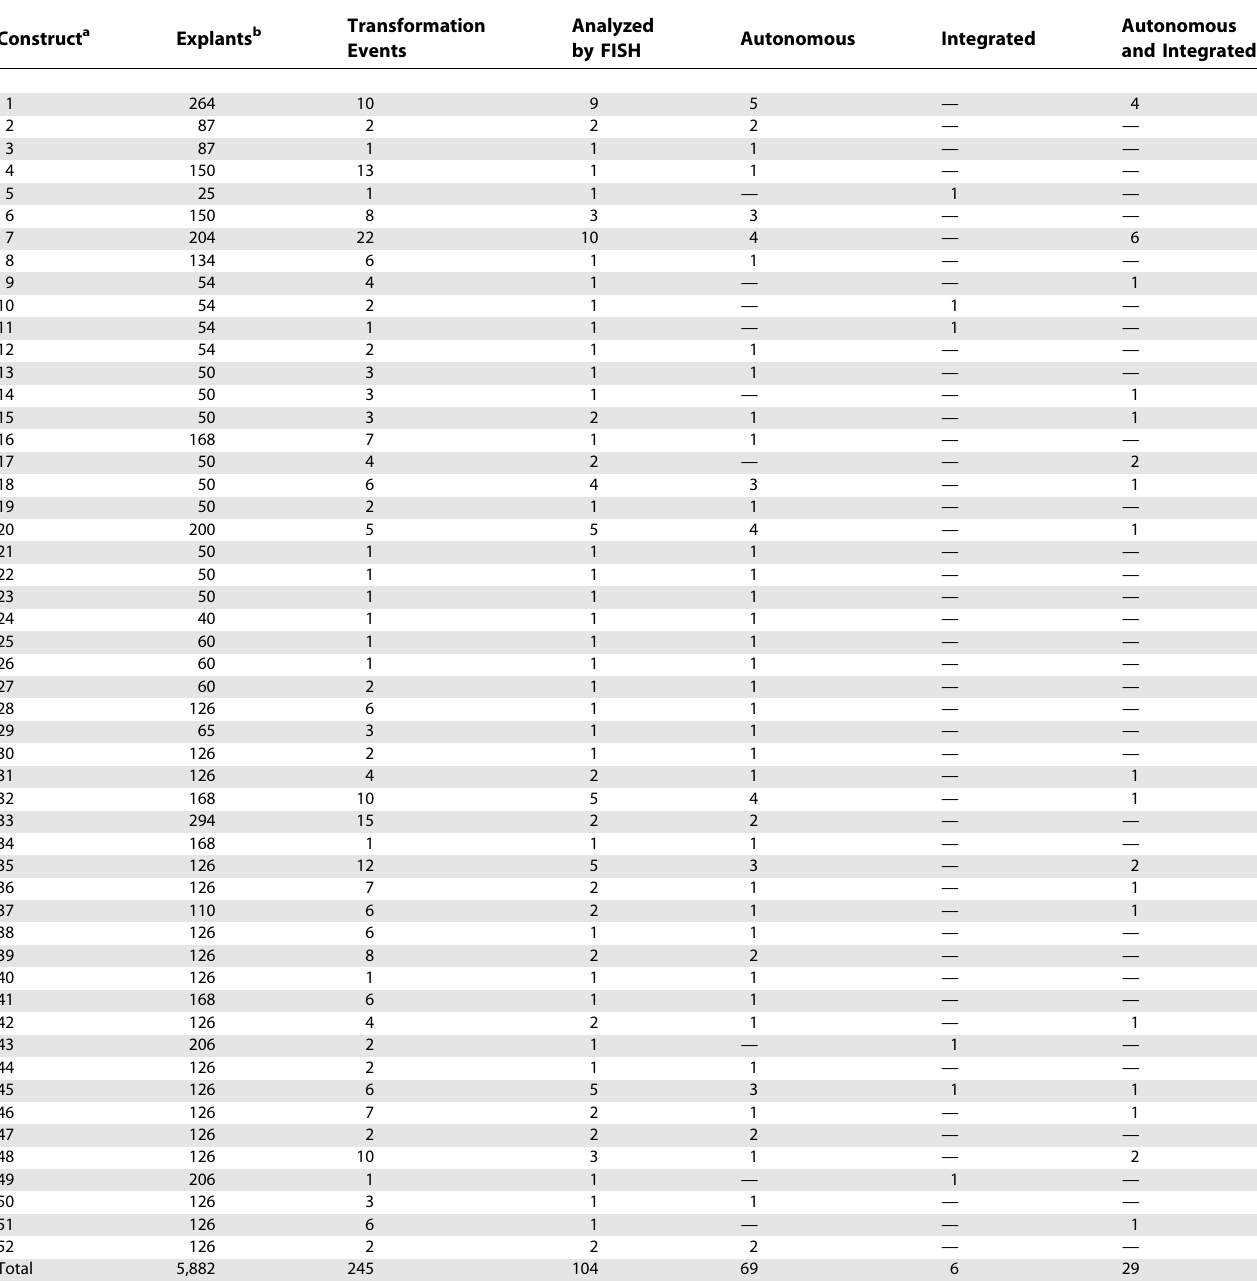
Table 2. MMC Transformation Events and FISH Analysis Construct